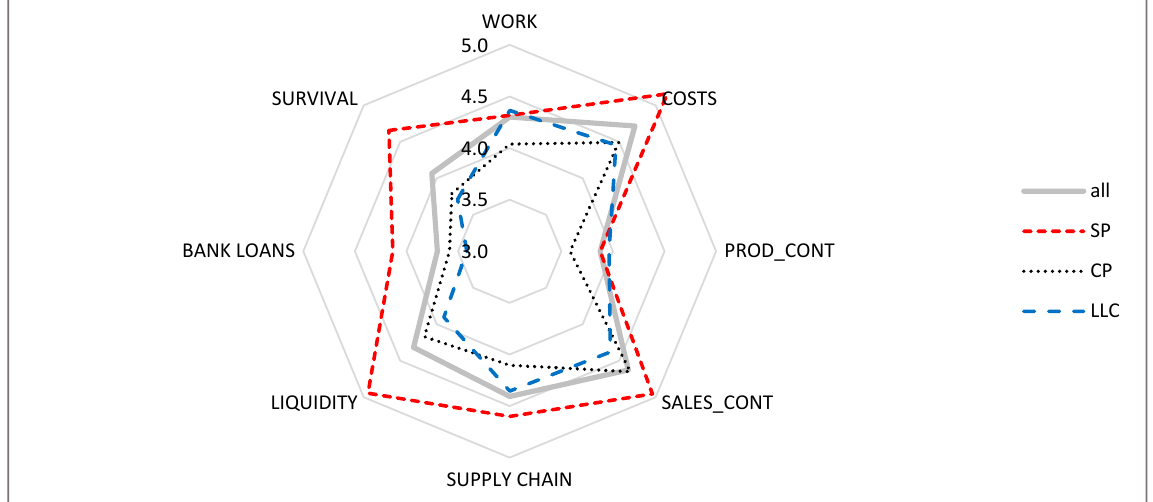
Figure 5. Perception of the COVID-19 interruptions and business organization form (OWN_2).